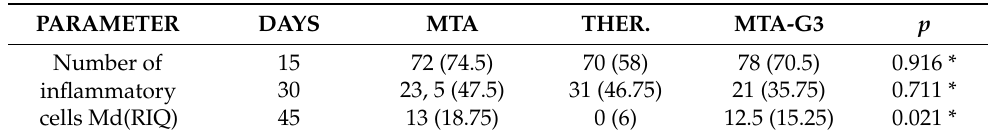
Table 3. Number of inflammatory cells MTA, Theracal and MTA-G3. Differences between materials according to periods.